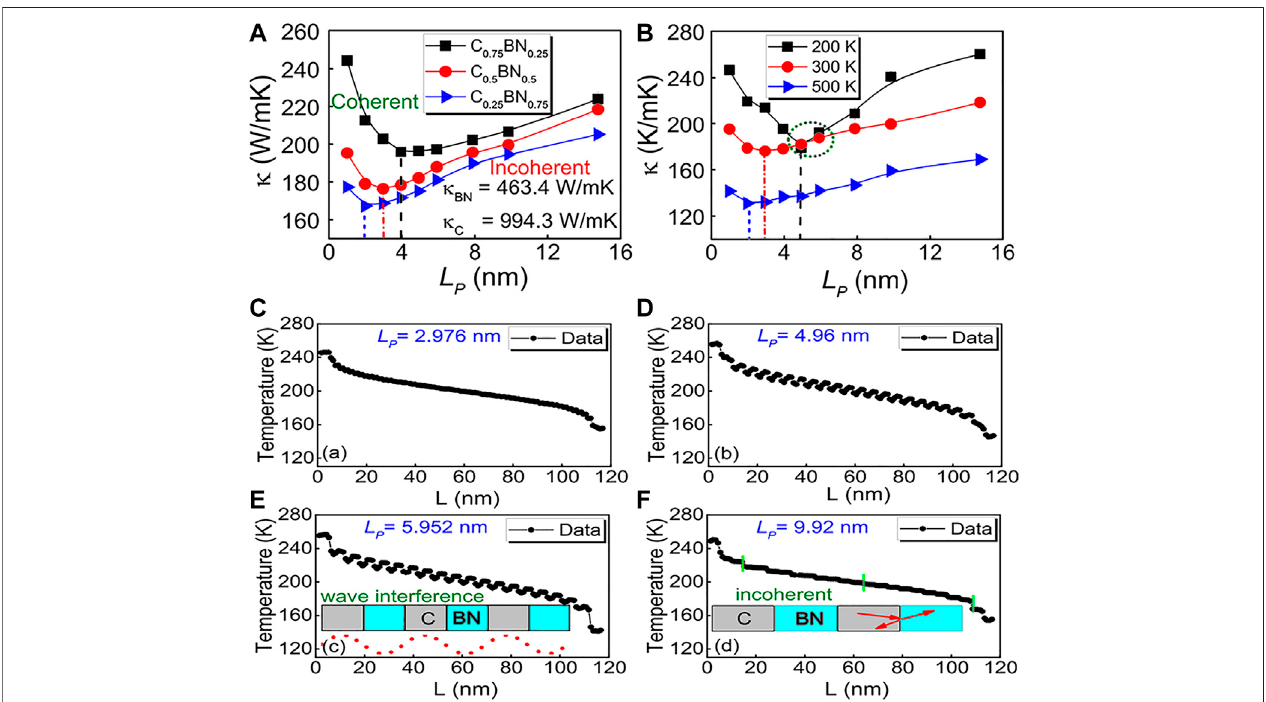
FIGURE4| Thethermalconductivityofgraphene/h-BNsuperlatticeasafunctionof l P (A) fordifferenth-BNproportions, (B) atdifferenttemperatures.Steadystate temperaturepro fi lesofgraphene/h-BNsuperlatticewith (C) l P (cid:1) 2 . 976nm, (D) l P (cid:1) 4 . 96nm, (E) l P (cid:1) 5 . 952nmand (F) l P (cid:1) 9 . 92nmat200 K.Itisworthpointingoutthat for some speci fi c l P , the temperature pro fi le clearly behaves wave-like, suggesting that the number on the curves don ’ t represent the real temperature originating from random atom motion. Reproduced from (Chen et al., 2016c) with permission from AIP Publishing LLC.